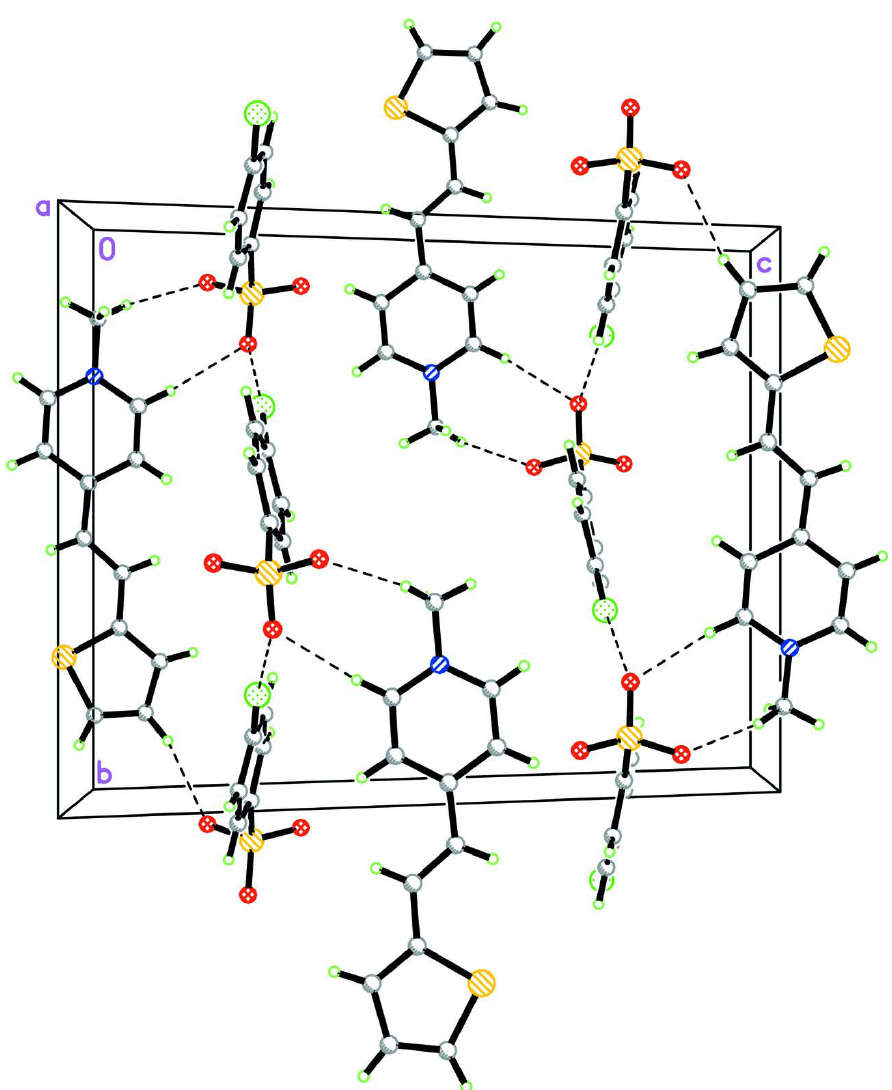
The packing diagram of the title structure viewed along the a axis. The weak C—H···O and C—H···S interactions are drawn as dashed